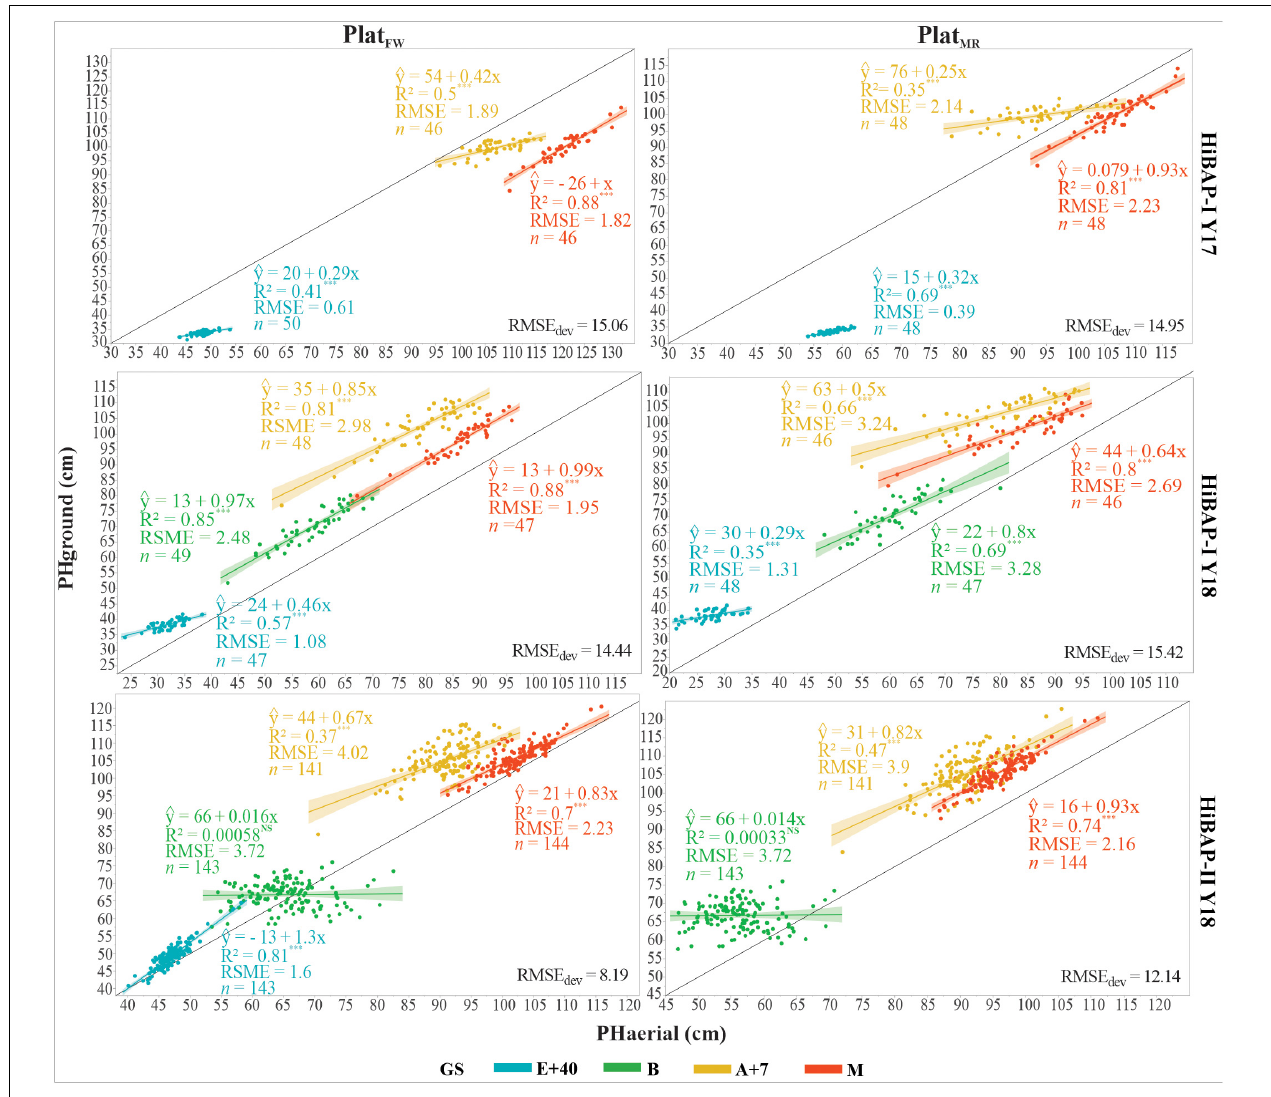
FIGURE 6 | Linear relationship between plant height (PH, cm) estimated from the unmanned aerial vehicle (UAV-based) data (PHaerial) and that ground-truth measured manually (PHground), as well as RMSE, and the number ( n ) of genotypes considered at four growth stages (GS): 40 days after emergence (E + 40), booting (B), 7 days after flowering (A + 7), and at physiological maturity (M) for Plat FW and Plat MR considering all locations in this study. Black solid line shows the 1:1 lines; light shadow color represents a 99% confidence interval. The RMSE dev in the bottom right represents the deviation between the PHaerial and the PHground across GS. ∗∗∗ indicate p -value of the coefficient of determination ( R 2 ), with ∗∗∗ P < 0.001; NS, non-significative value.